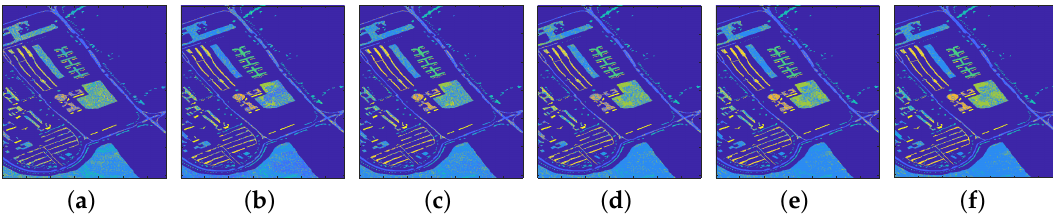
Figure 11. KNN classification maps of using the ten bands selected by different methods from the Pavia University dataset. ( a ) MVPCA ( b ) LCMVBCC ( c ) LCMVBCM ( d ) ECA ( e ) OPBS ( f )